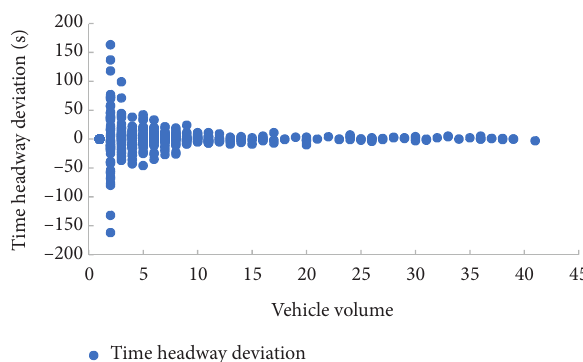
Figure 8: Time headway deviation with hourly vehicle